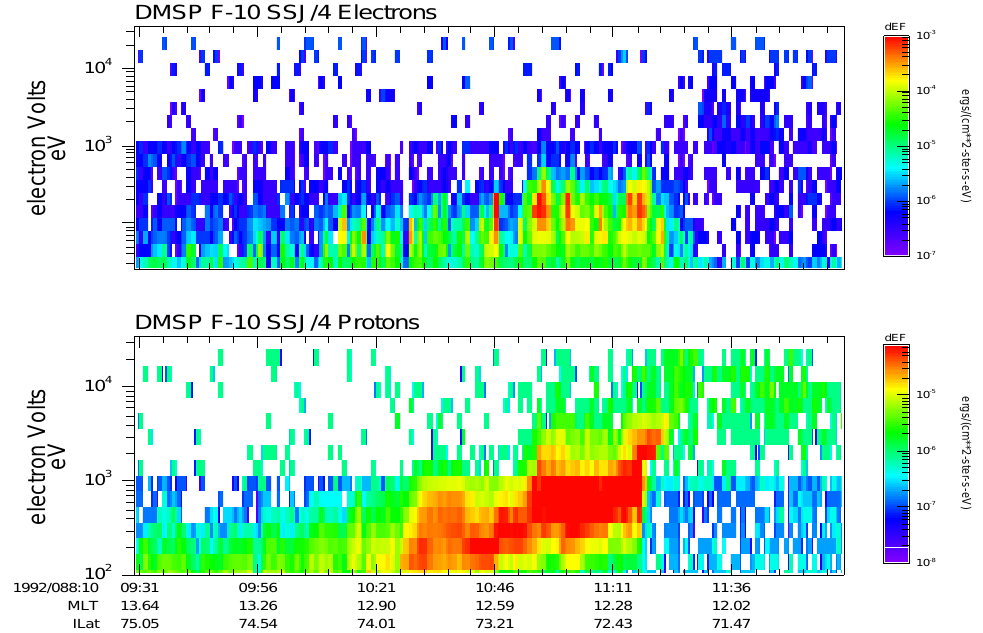
Fig. 4. DMSP F-10 data from 28 March 1992; a dispersion signature can be seen along with a lopsided V. The upper spectrogram is electrons, while the lower is